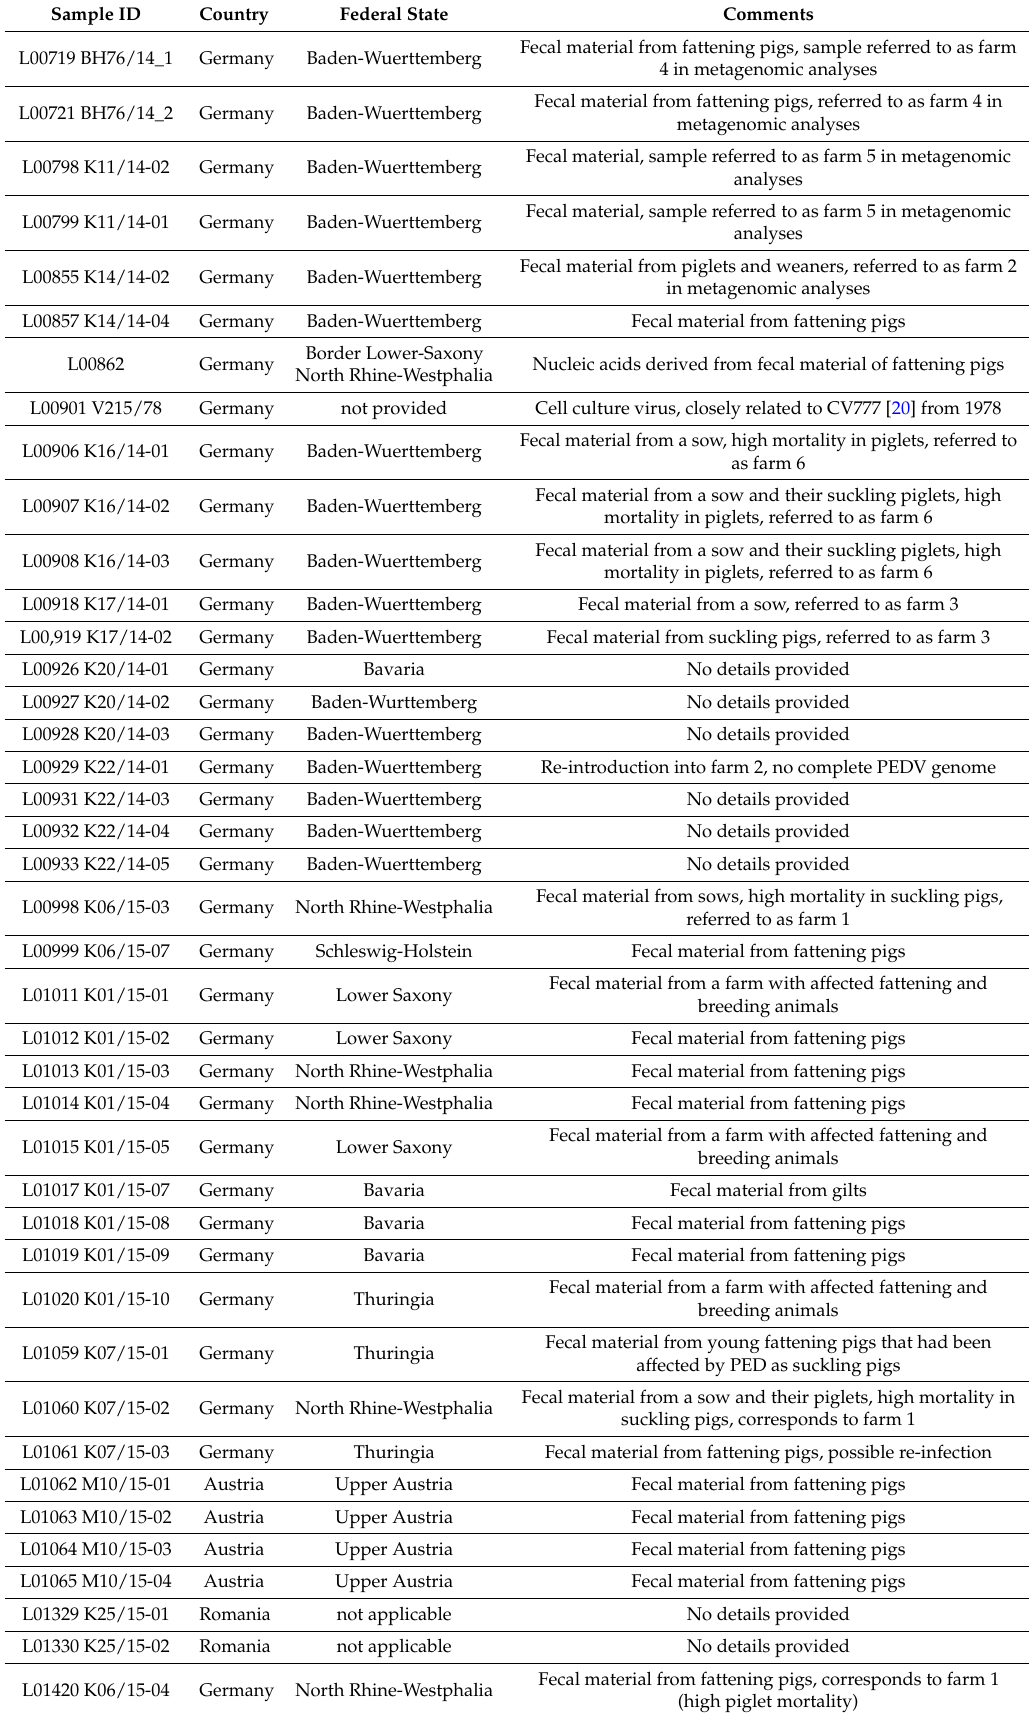
Table 1. Details and metadata of samples investigated in this